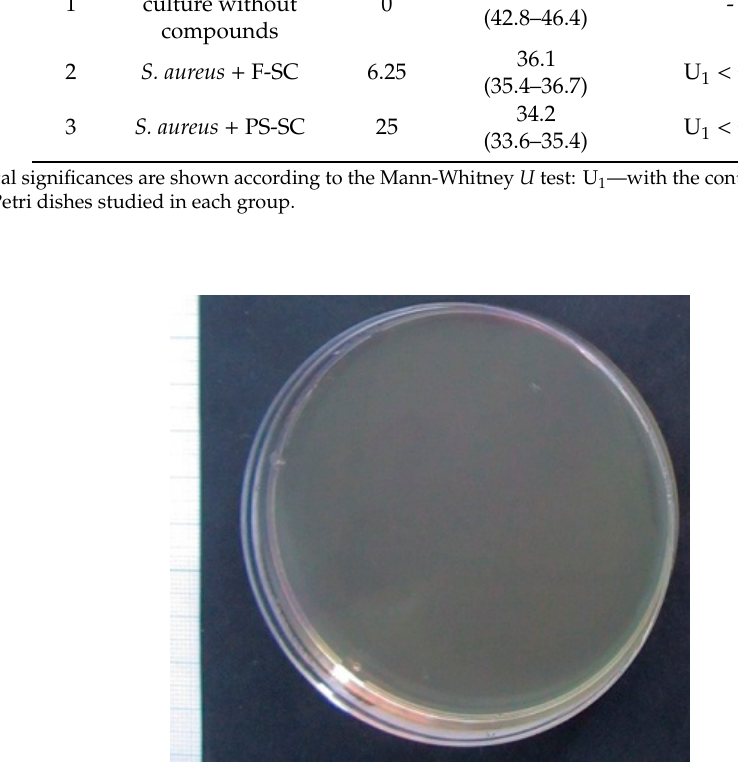
Figure 2. Growth of S. aureus strain 209P inhibited for 24 h after spending 24 h in a preliminary mixture with F-SC at a dose of 50 g/L.